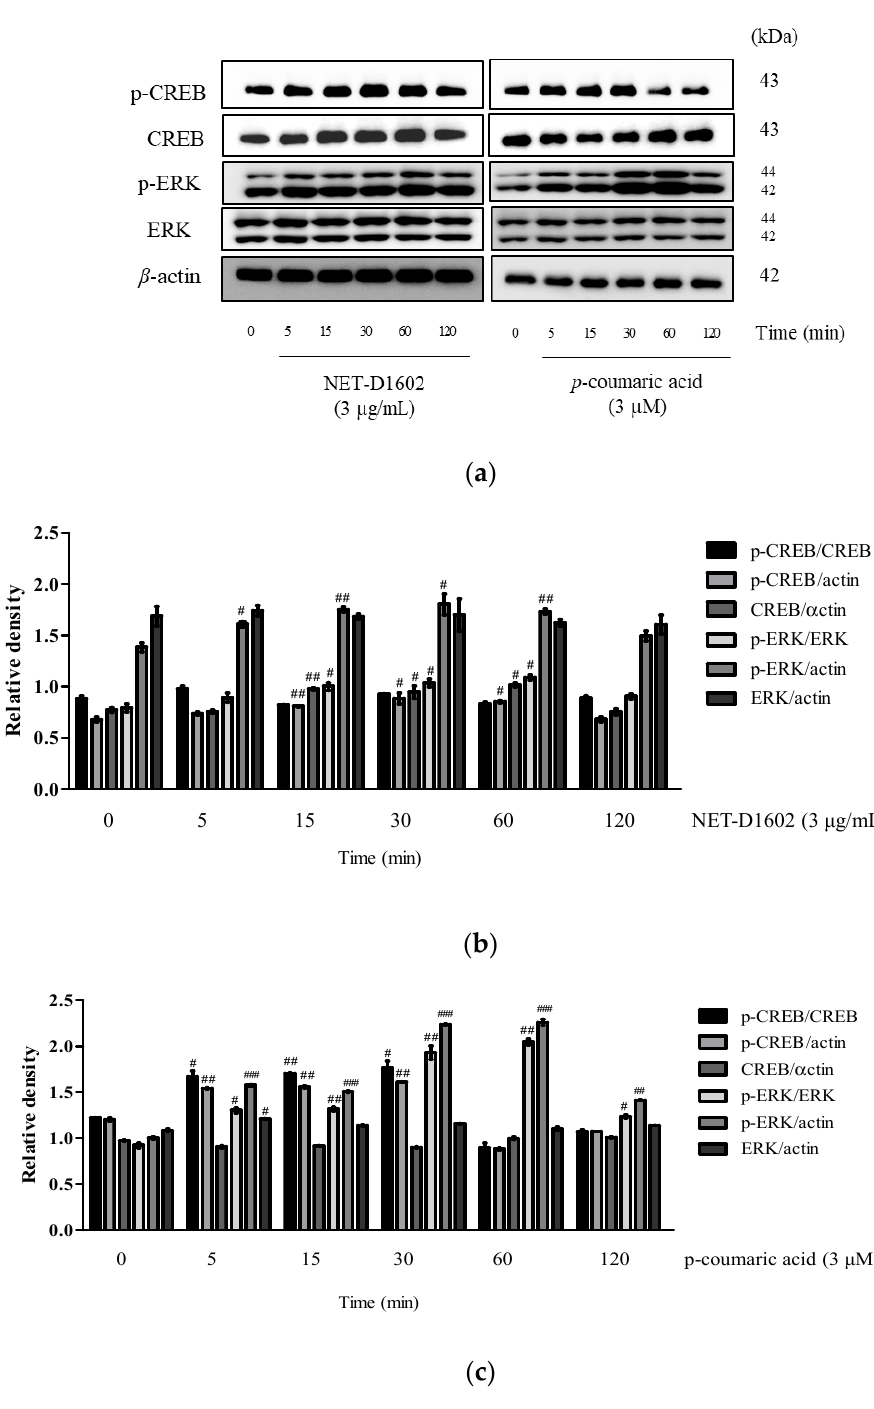
Figure 5. Effects of NET-D1602 and p- coumaric acid on ERK1/2 and CREB phosphorylation in primary cultured rat cortical neurons. ( a ) Primary cultured cortical neurons were treated with NET-D1602 or p- coumaric acid for the indicated time periods, and cell lysates were analyzed by using Western blotting. ( b , c ) Quantitative analysis of ERK and CREB protein levels normalized against β -actin level. # p < 0.05, ## p < 0.01, and ### p < 0.001 compared to that of the untreated group. CREB, cyclic AMP-responsive element-binding protein; ERKs, extracellular signal-regulated kinases; NET-D1602, HP-20 resin fraction of the water extract of Vaccinium bracteatum leaves.